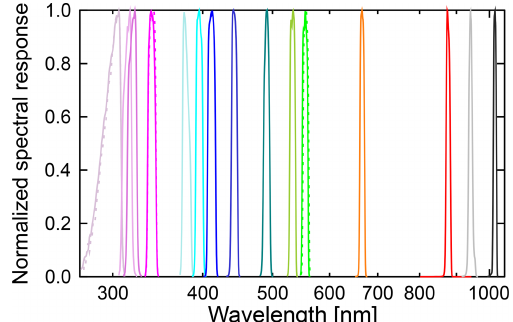
Figure 3. Normalized spectral response functions of the GUVis- 3511 radiometer discussed in this study. Functions were measured with BSI’s spectral tester (Bernhard et al., 2005a) and corrected for the finite bandpass of the tester using a simple deconvolution routine also described by Bernhard et al. (2005a). Color coding is identical to that in Fig. 8. Note that the x axis is logarithmic to emphasize the UV range. A version of the figure, plotted separately for UV, visible, and IR wavelengths, is part of the Supplement.